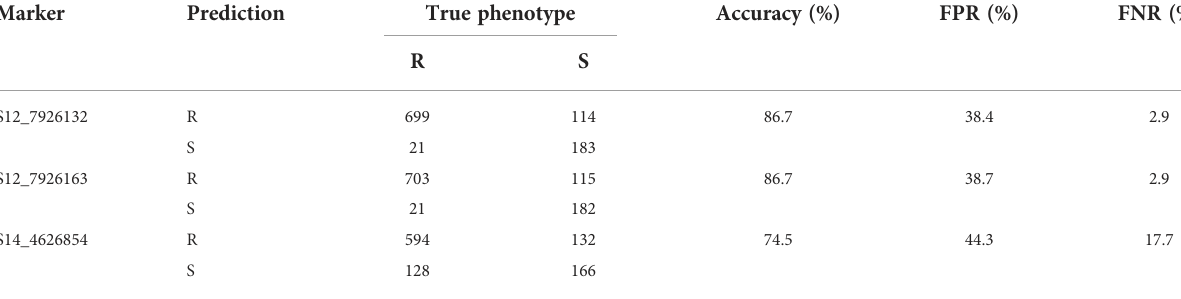
TABLE 4 Predictive ability of three KASP markers for CMD in Uganda ’ s cassava breeding population.